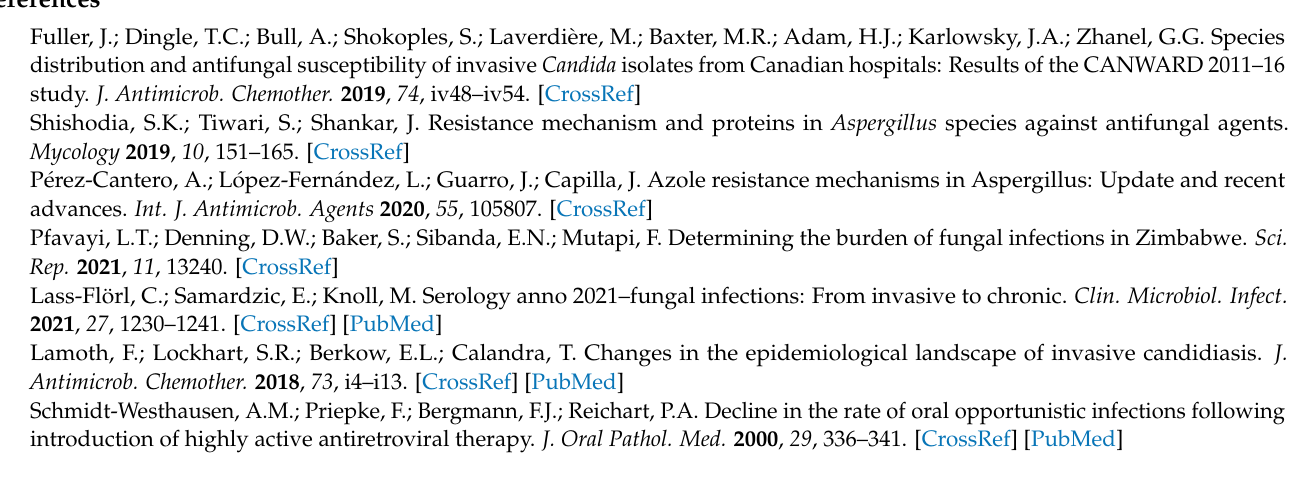
Figure S6: 2D NMR spectra of the purified antifungal compound of Lysinibacillus isolate (A) HMBC spectrum, (B) HSQC spectrum and (C) COSY